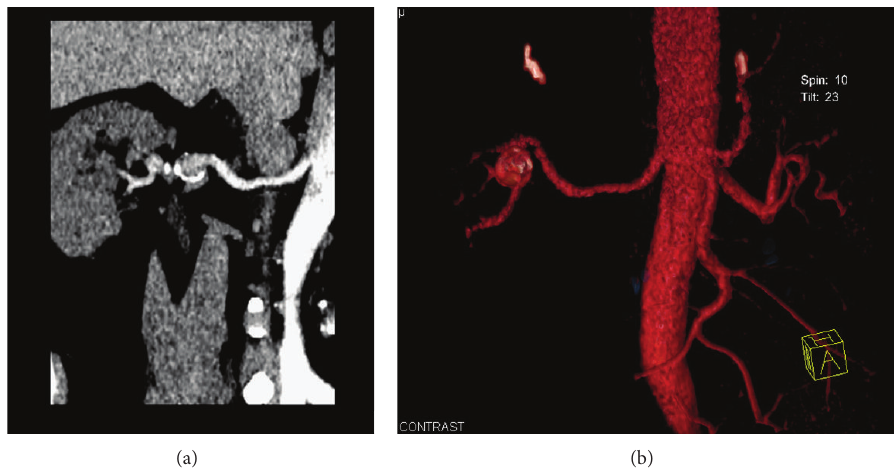
Figure 4: (a) Curved reconstructed image along the right renal artery visualizing in a better way the saccular shape of the aneurysm and the central enhancement from the contrast flow within it. (b) 3D volume rendering technique image of the right renal artery demonstrating the detected aneurysm in an illustrative way and providing us with its detailed